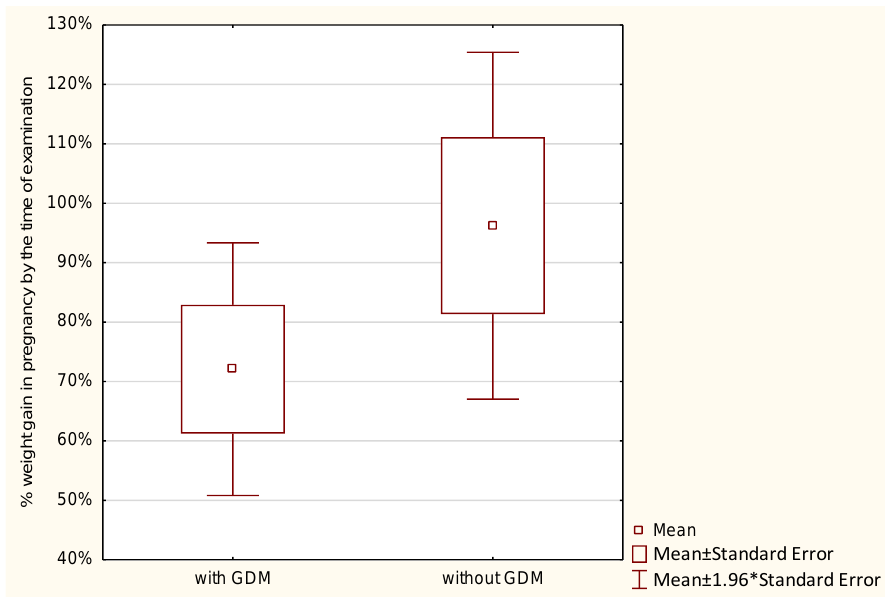
Figure 4. The percentage of GWG by the time of examination performed in pregnant women with a BMI of 18.5 – 24.9.